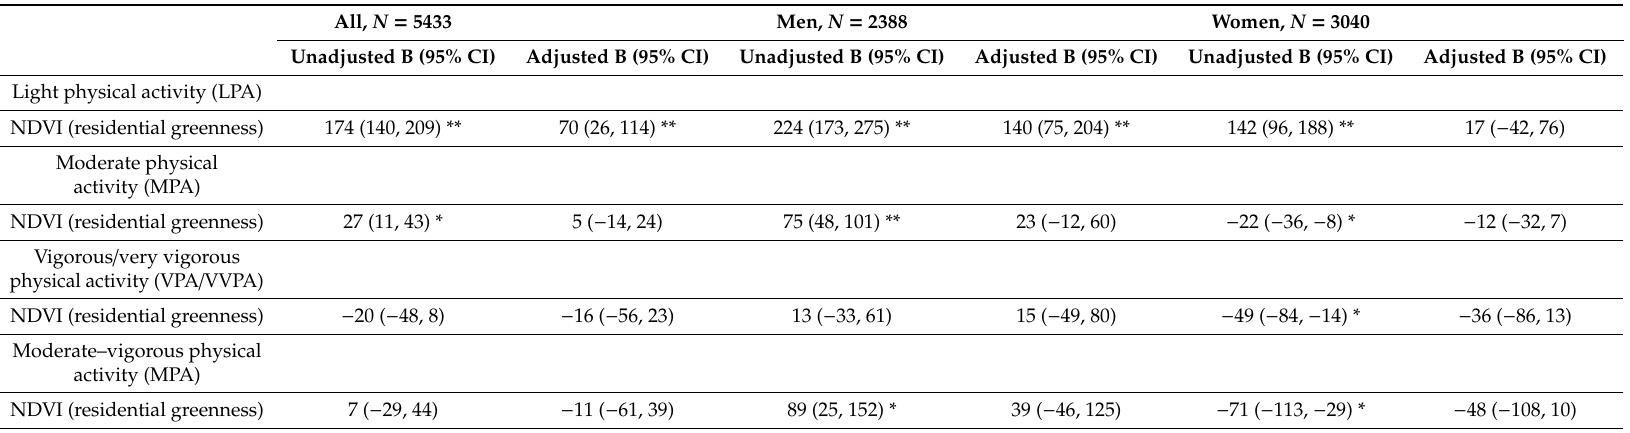
Table 3. Association between residential greenness (NDVI) and accelerometry measured LPA, MPA, VPA / VVPA, and MVPA (daily average minutes of MET-minutes) among middle-aged adults and men and women separately according to multivariable linear